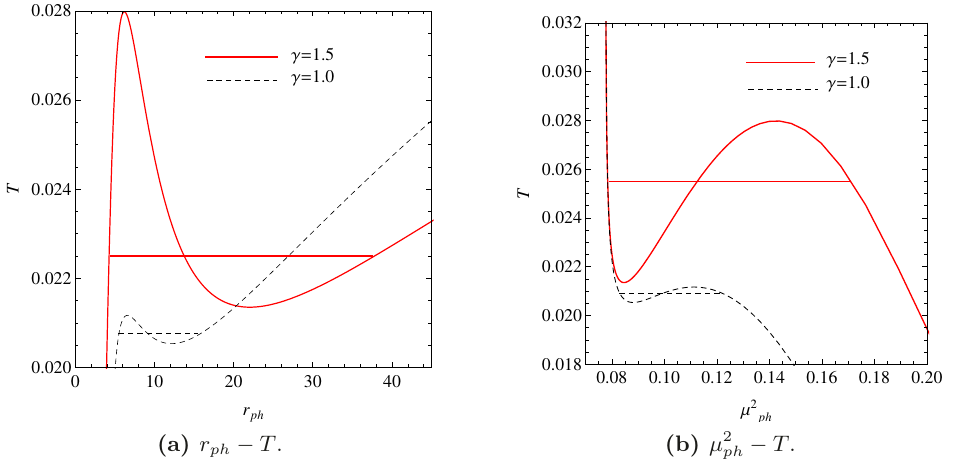
Figure 8. The pressures set to P c